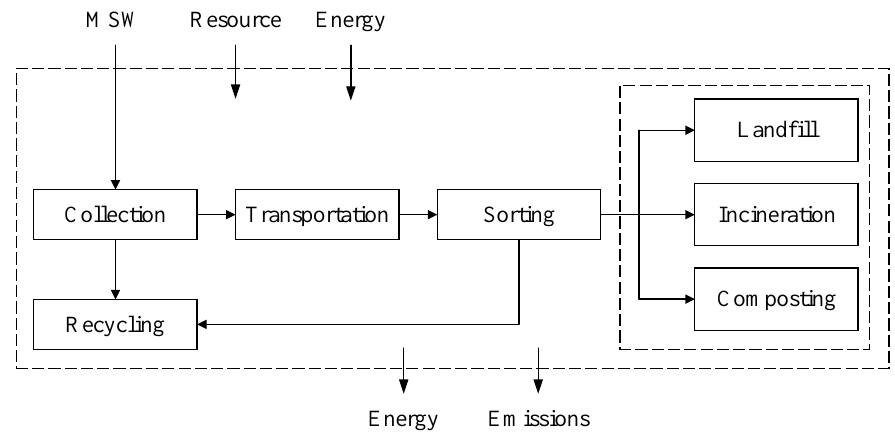
Figure 5. Generic system boundaries of municipal solid waste management (MSWM) systems under study. MSW, municipal solid waste.